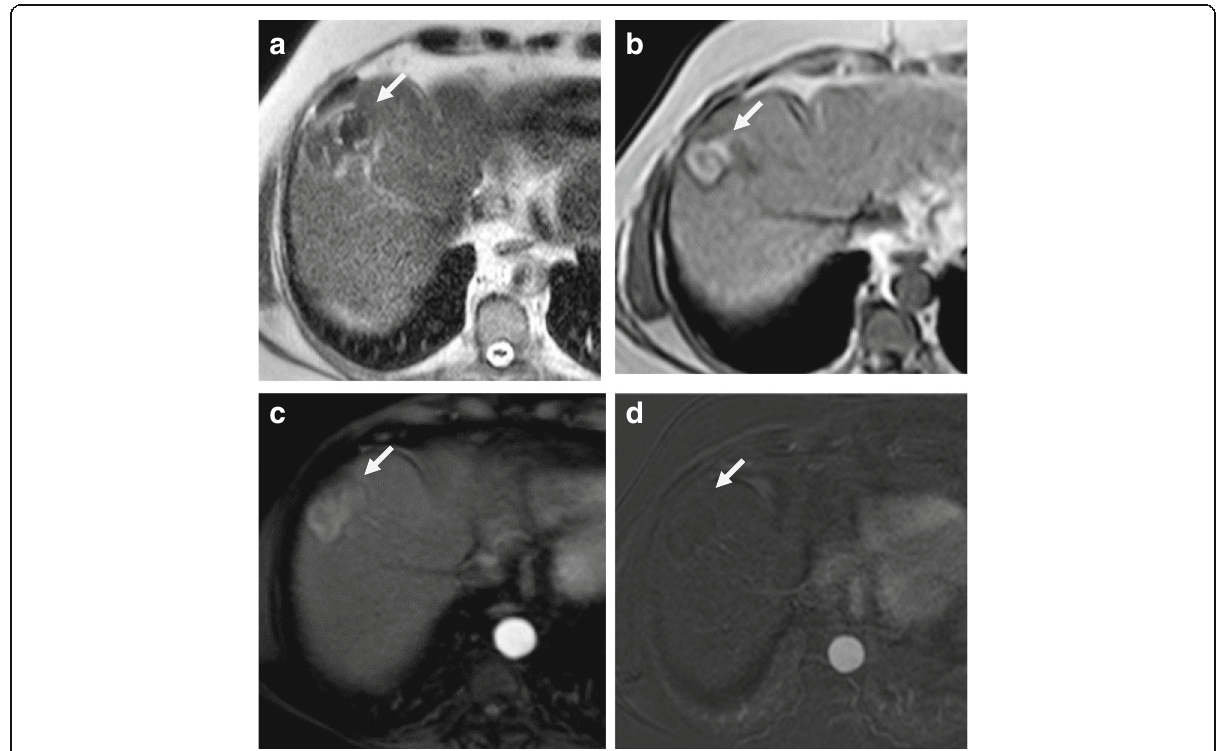
Fig. 3 LR-TR nonviable after RFA. a T2-WI shows that the treated lesion (arrow) has a low signal lesion (arrow). b T1-WI before contrast shows a high signal of the lesion. c Enhanced T1-WI in the arterial phase shows a high signal of the lesion that can be misinterpreted as an arterial hyperenhancing focal lesion. d Subtracted image of the enhanced T1-WI from the non-enhanced T1-WI shows no appreciable